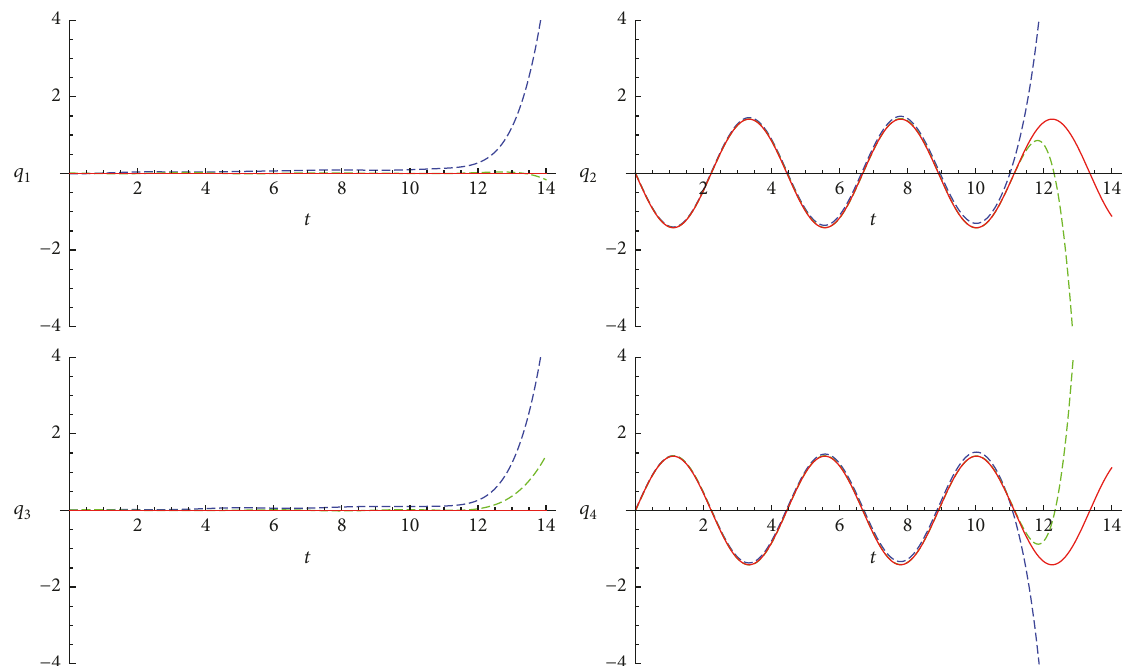
Figure 3: The curves of solutions of (5): the red curve is an approximate √2𝜋 -periodic solution starting from 𝑃 3 , while the blue dashed curve and the green dashed curve are the reference solutions starting from 𝑄 31 and 𝑄 32 ,